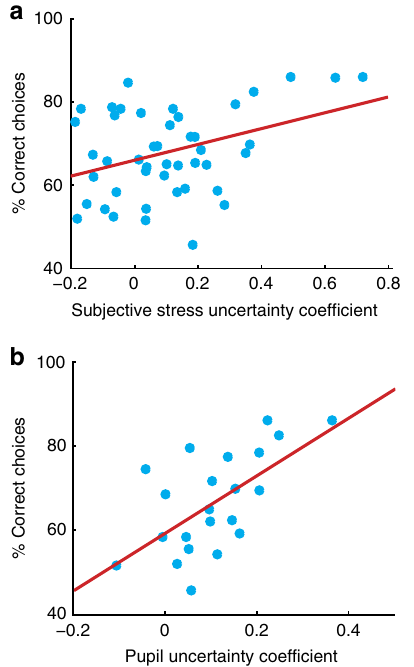
Figure 6 | Relationship between uncertainty sensitivity and task performance. ( a ) Subjective stress sensitivity (the regression coefficient for uncertainty in the subjective stress model) correlated with how frequently participants predicted the correct outcome (Pearson correlation, n ¼ 45, r ¼ 0.37, P ¼ 0.012). ( b ) Pupillary sensitivity to uncertainty also predicted performance (Pearson correlation, n ¼ 22, r ¼ 0.62, P ¼ 0.0023). Each data point is one